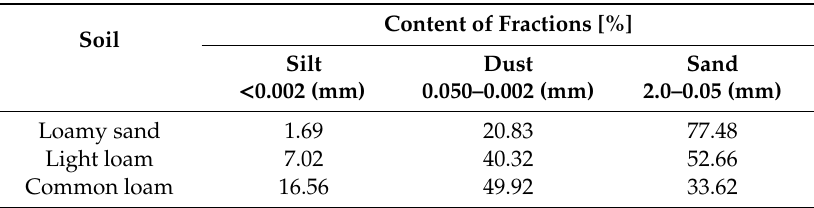
Table 2. Grain-size distribution of